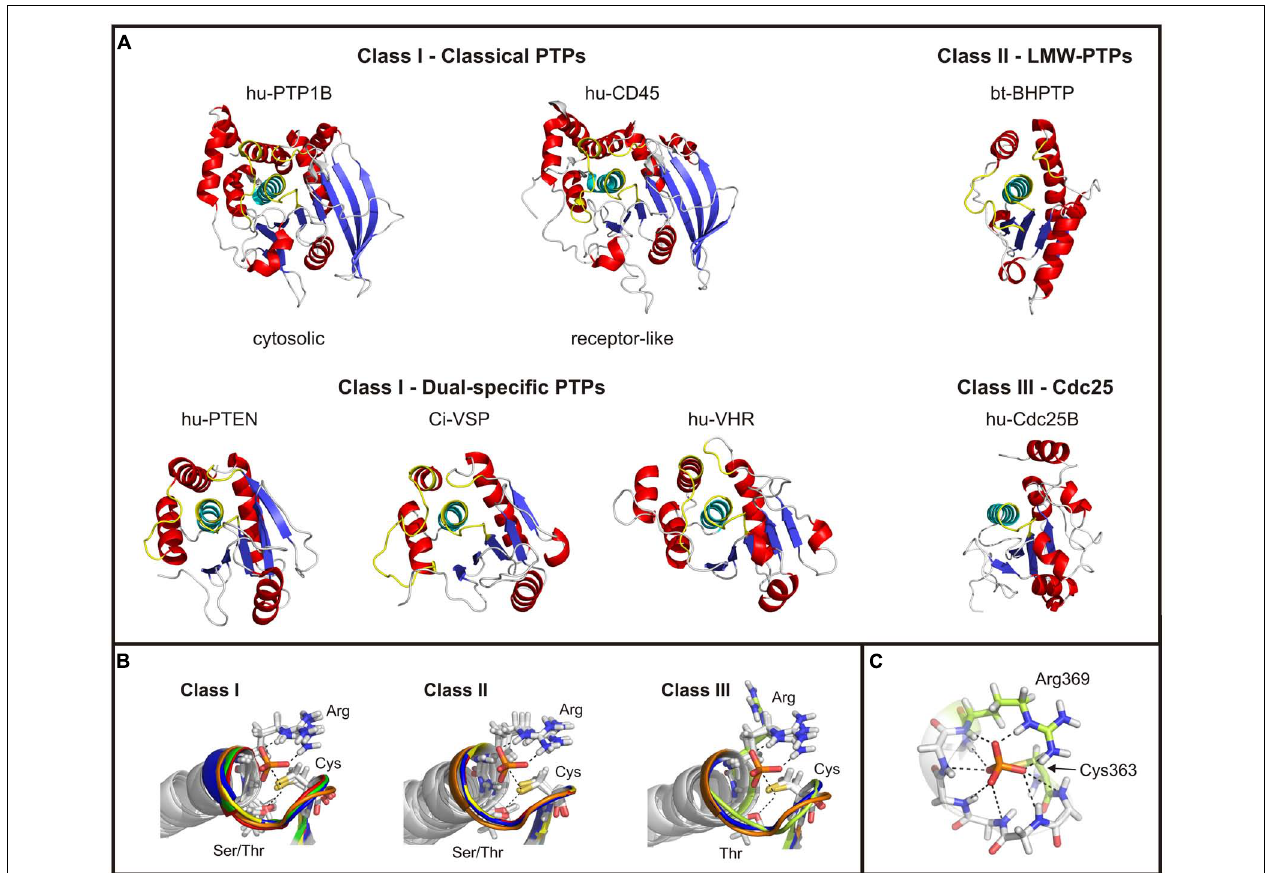
FIGURE 2 | Structural comparison of the catalytic domains of cysteine-based PTPs. (A) Catalytic domains of exemplary chosen phosphatases are shown.The twisted β -sheet core is colored in blue; the α -helices surrounding the core are shown in red.The α -helix C-terminal to the active site loop is depicted in cyan, and the regions corresponding to the P-, TI- andWPD-loop of class I PTPs in yellow (see text for details). In case of Cdc25s, noTI- andWPD-loop exist.The structure of Ci-VSP was taken from the MD simulation (Hobiger etal., 2013) which was performed on the basis of the crystal structure by Matsuda etal. (2011; PDB accession number 3awe). All other structures were created based on the crystal structures available in the RCSB protein data bank.The accession numbers are: 1nwe (hu-PTP1B), 1ygu (hu-CD45. Here, the catalytically active domain D1 is shown.), 1d5r (hu-PTEN), 1vhr (hu-VHR), 1dg9 (bt-BHPTP), and 1qb0 (hu-Cdc25B).